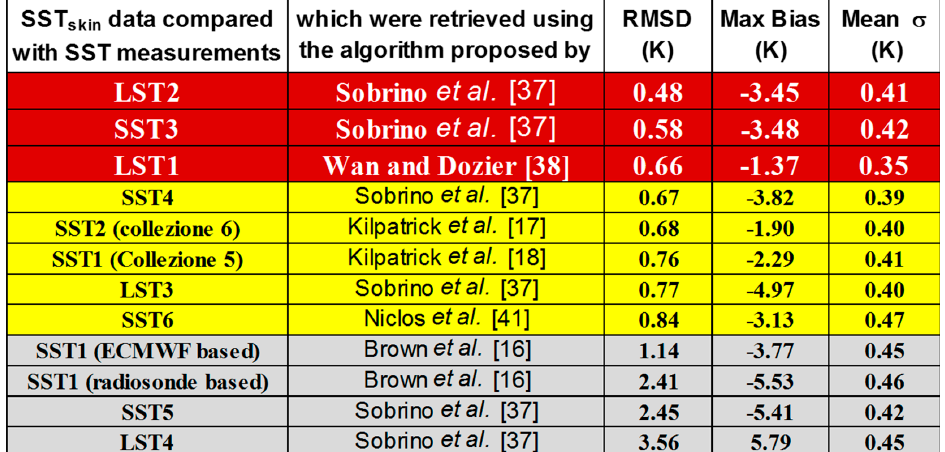
Figure 2. The ranking of split window (SW) techniques for retrieving land surface temperature (LST) and sea surface temperature (SST) measurements from MODIS images based on root-mean-square deviation (RMDS) values between SST skin data and SST1 (radiosonde based) , SST1 (ECMWF based) , SST1 (collection 5) , SST2 (collection 6) , SST3, SST4, SST5, SST6, LST1, LST2, LST3, and LST4 measurements.